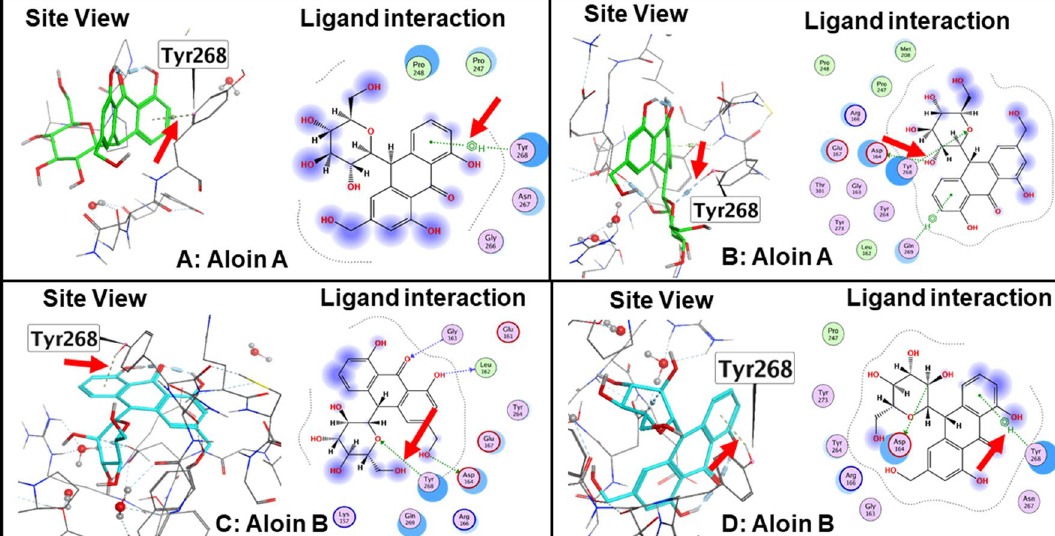
Figure 4. Structural analysis of interaction of aloin isomers with SARS-CoV-2 PLpro. ( A ) Interaction of aloin A orientation-1 with Tyr 268 of PLpro through hydrogen bonding. ( B ) Interaction of aloin A orientation-2 with Tyr 268 of PLpro through hydrogen bonding. ( C ) Interaction of aloin B orientation-1 with Tyr 268 of PLpro through hydrogen bonding. ( D ) Interaction of aloin B orientation-2 with Tyr 268 of PLpro through hydrogen bonding. Site view and ligand interaction maps were presented to illustrate the hydrogen bonding.